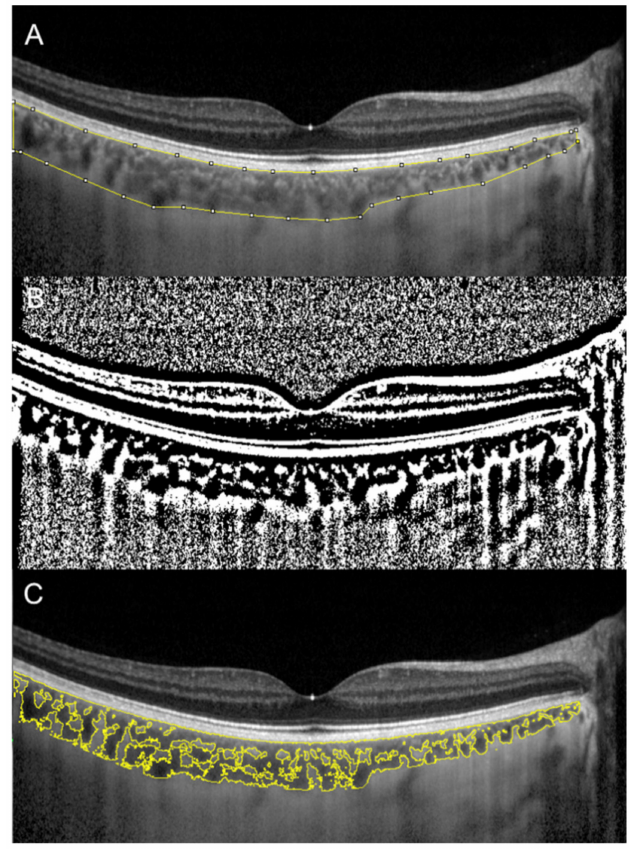
Figure 1. Choroidal vascularity index (CVI) calculation with binarization of enhanced-depth imaging (EDI) spectral domain optical coherence tomography (SD-OCT) image. Choroidal boundaries were traced to identify the total choroidal area (yellow lines) ( A ). The image was binarized using Niblack’s auto-local threshold ( B ). The color threshold tool was used to select the dark pixels, representing the luminal area (yellow lines) ( C ). The CVI is calculated dividing luminal area by total choroidal